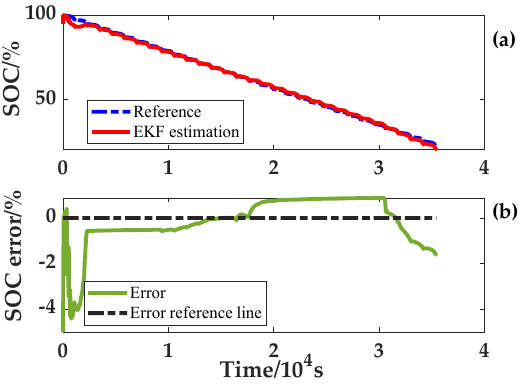
Figure 14. SOC estimation result and error of the temperature rise experiment. ( a ) SOC estimation result and ( b ) SOC estimation error.